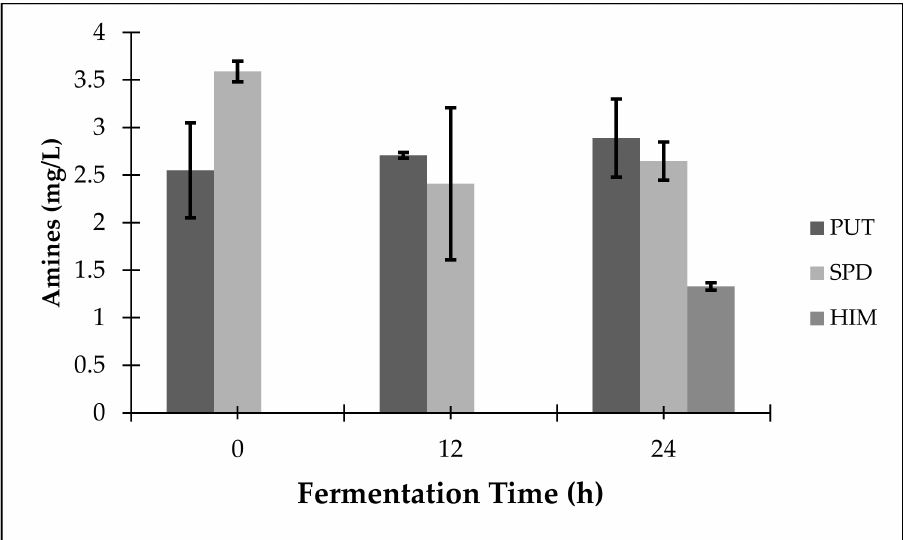
Figure 1. Levels of bioactive amines during the spontaneous fermentation of manipueira for tucupi production. HIM: histamine; PUT: putrescine; SPD: